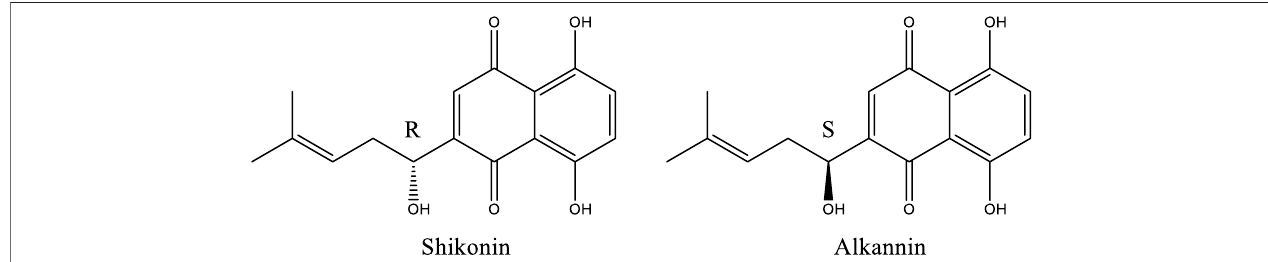
FIGURE 1 | Chemical structures of shikonin and alkannin.